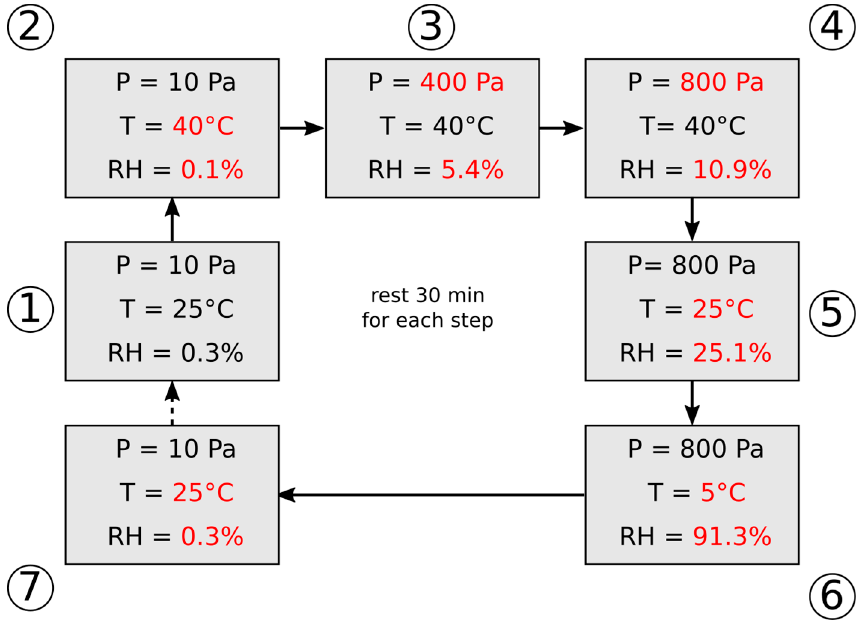
Figure 1. Schematic representation of environmental scanning electron microscopy (ESEM) analysis set-up.